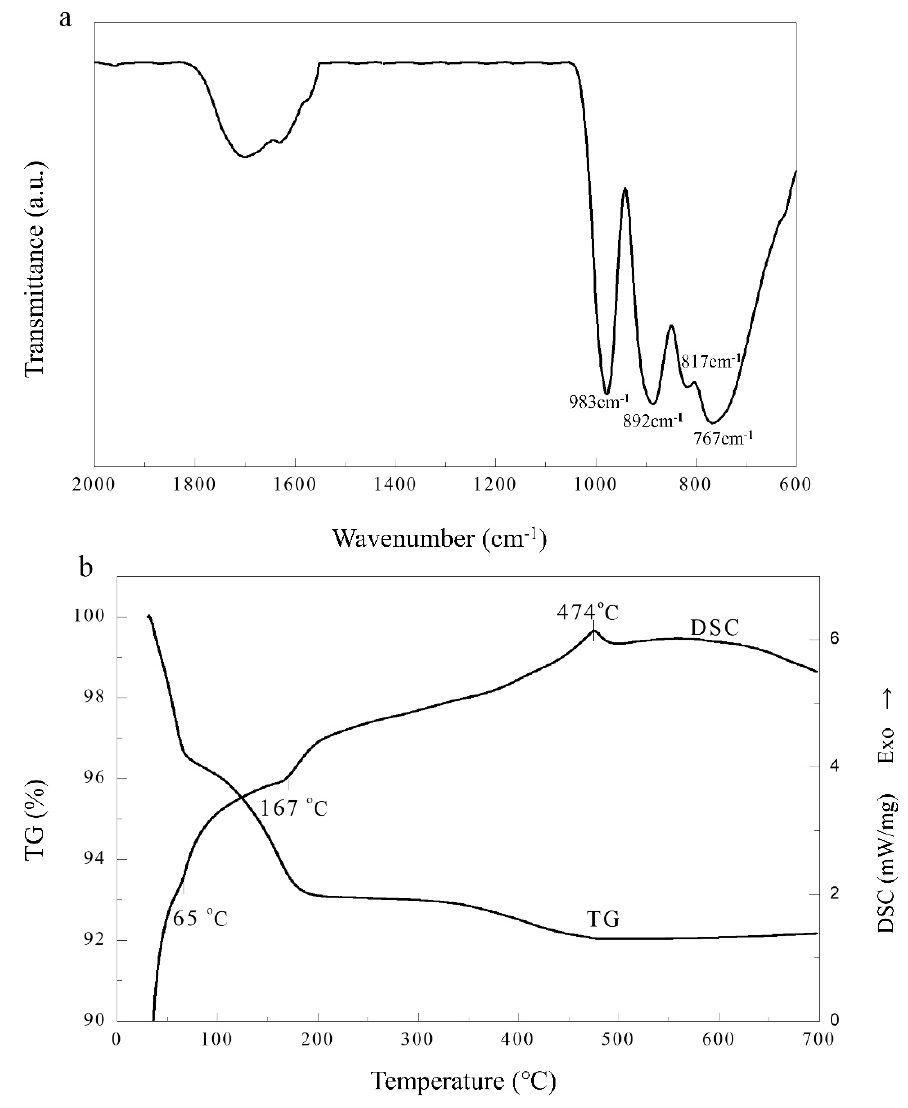
Figure 2. ( a ) FT-IR spectra of the H 4 GeW 12 O 40 . ( b ) TG–DSC curves of H 4 GeW 12 O 40 .